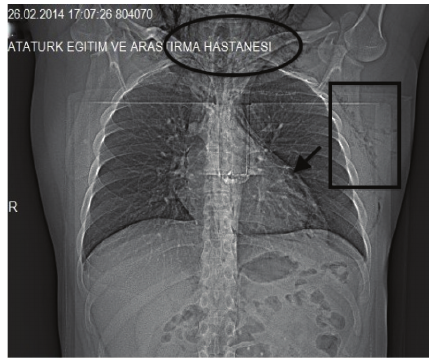
Figure 1: Subcutaneous air in the neck (oval) and in the axilla (rectangle) and air around the heart (arrow).